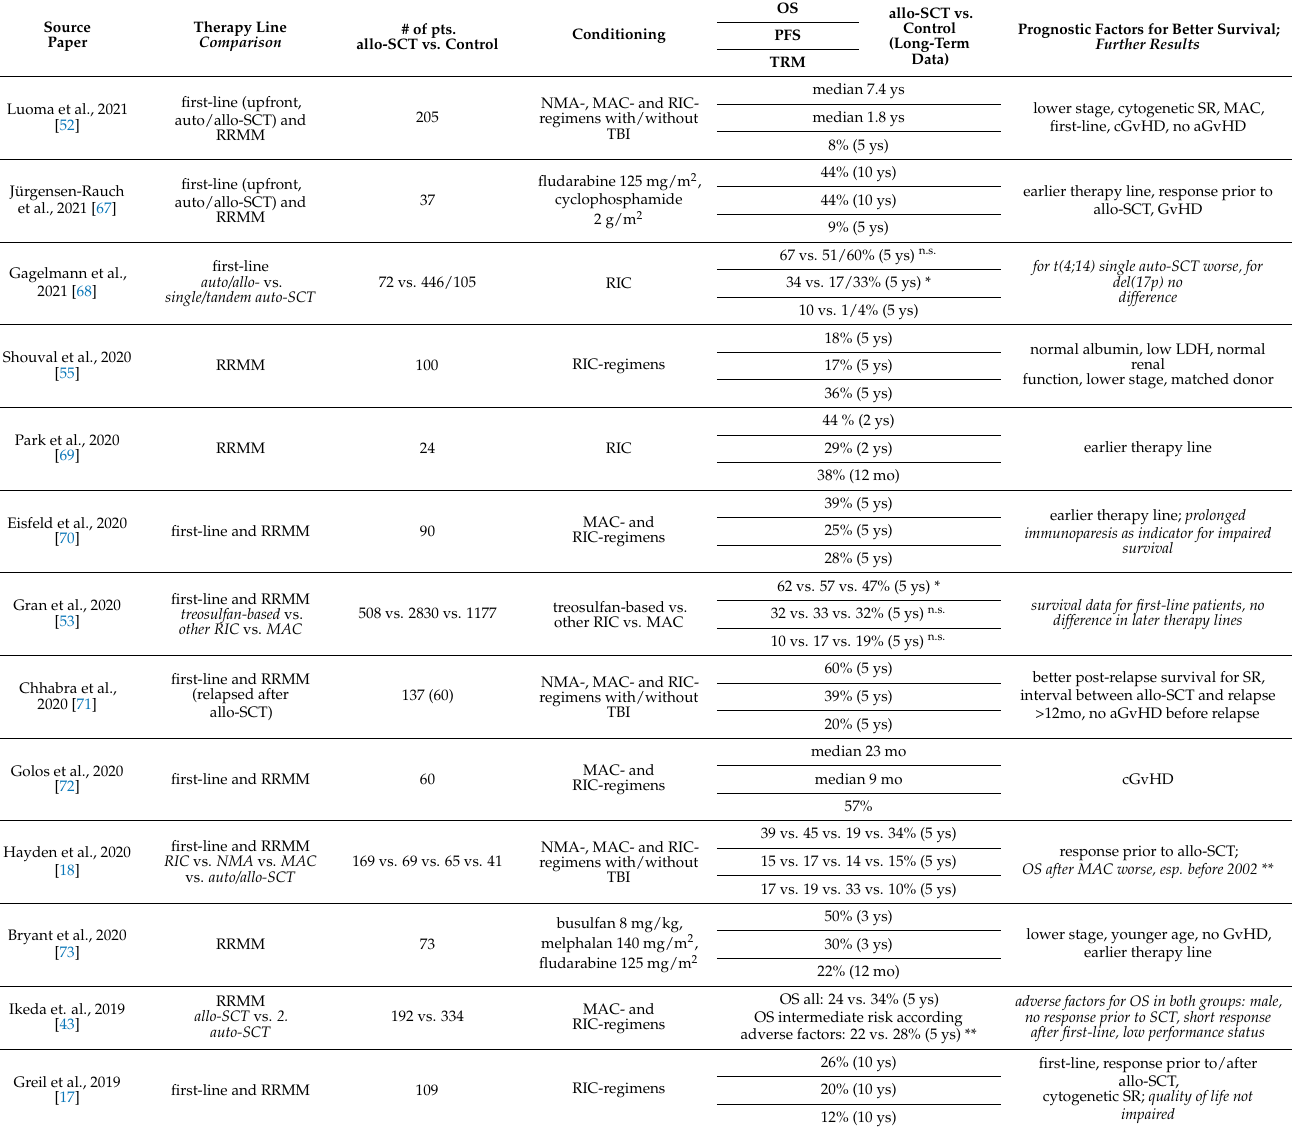
Table 2. Overview of retrospective trials on allo-SCT in MM, published in the last 5